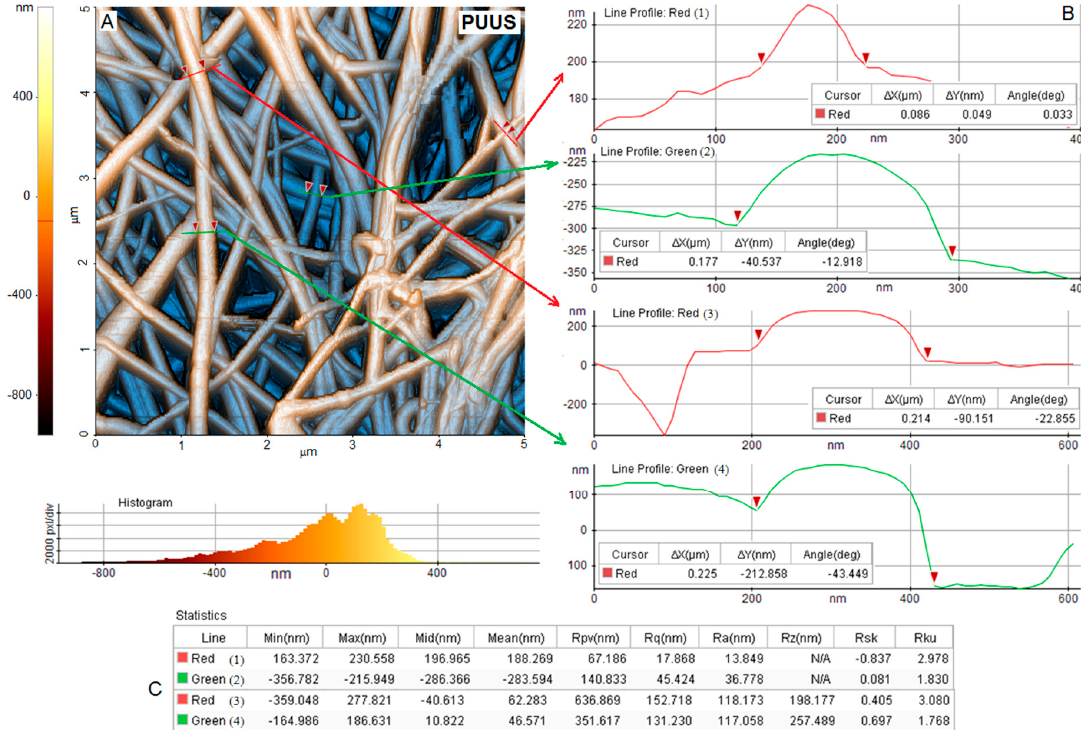
Figure 4. AFM morphology of PUUS nanofibrous mats: ( A ) 2D image of AFM analysis; ( B ) the diameters of four selected nanofibers (noted with red and green line); and ( C ) roughness values.